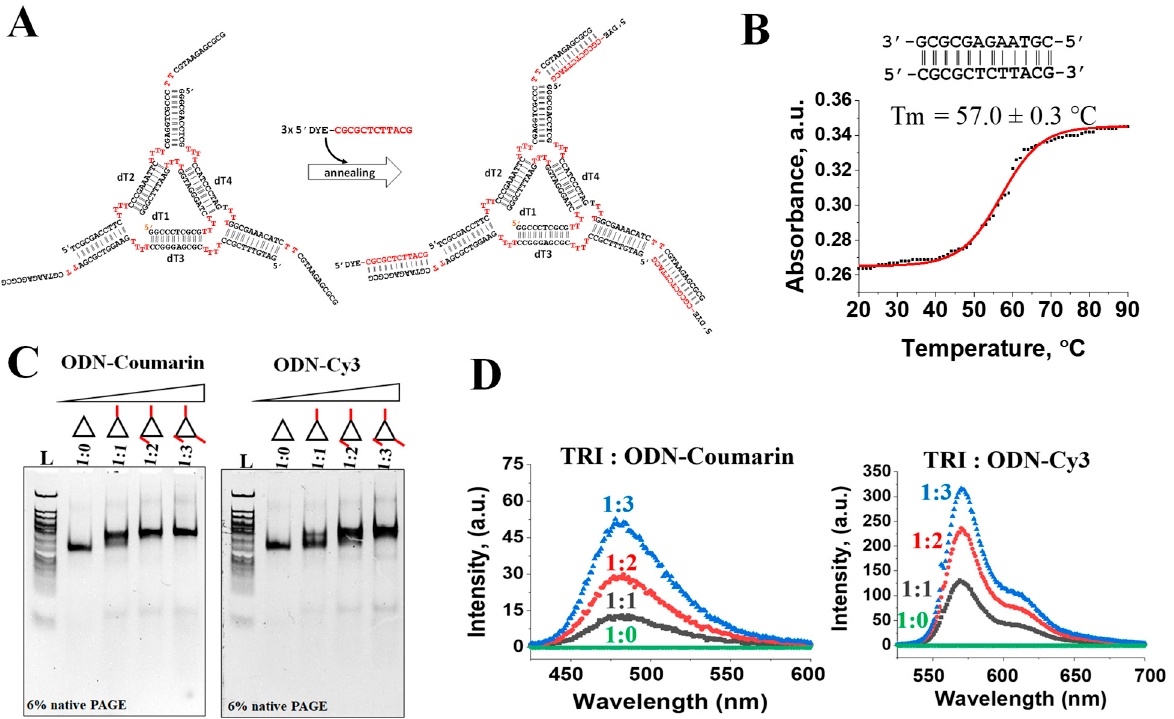
Figure 4. Hybridization of ODN conjugates with triangular-shaped nanoparticles. ( A ) Secondary structure and sequences of the DNA nanoconstruct representing three sticky-end regions complementary to the sequence of DNA-dyes. ( B ) Temperature-induced UV-absorbance profile of 1 µM DNA 12-base pairs in TMS buffer. Error corresponds to standard deviation in the mean. ( C ) Native PAGE analysis of the hybridization products upon saturation of the triangle nanoparticles with increasing number of DNA-conjugates to satisfy 1:0, 1:1, 1:2, and 1:3 stoichiometry ratios. ( D ). Fluorescence spectra of the triangular nanoparticles containing different numbers of the DNA-coupled dyes.